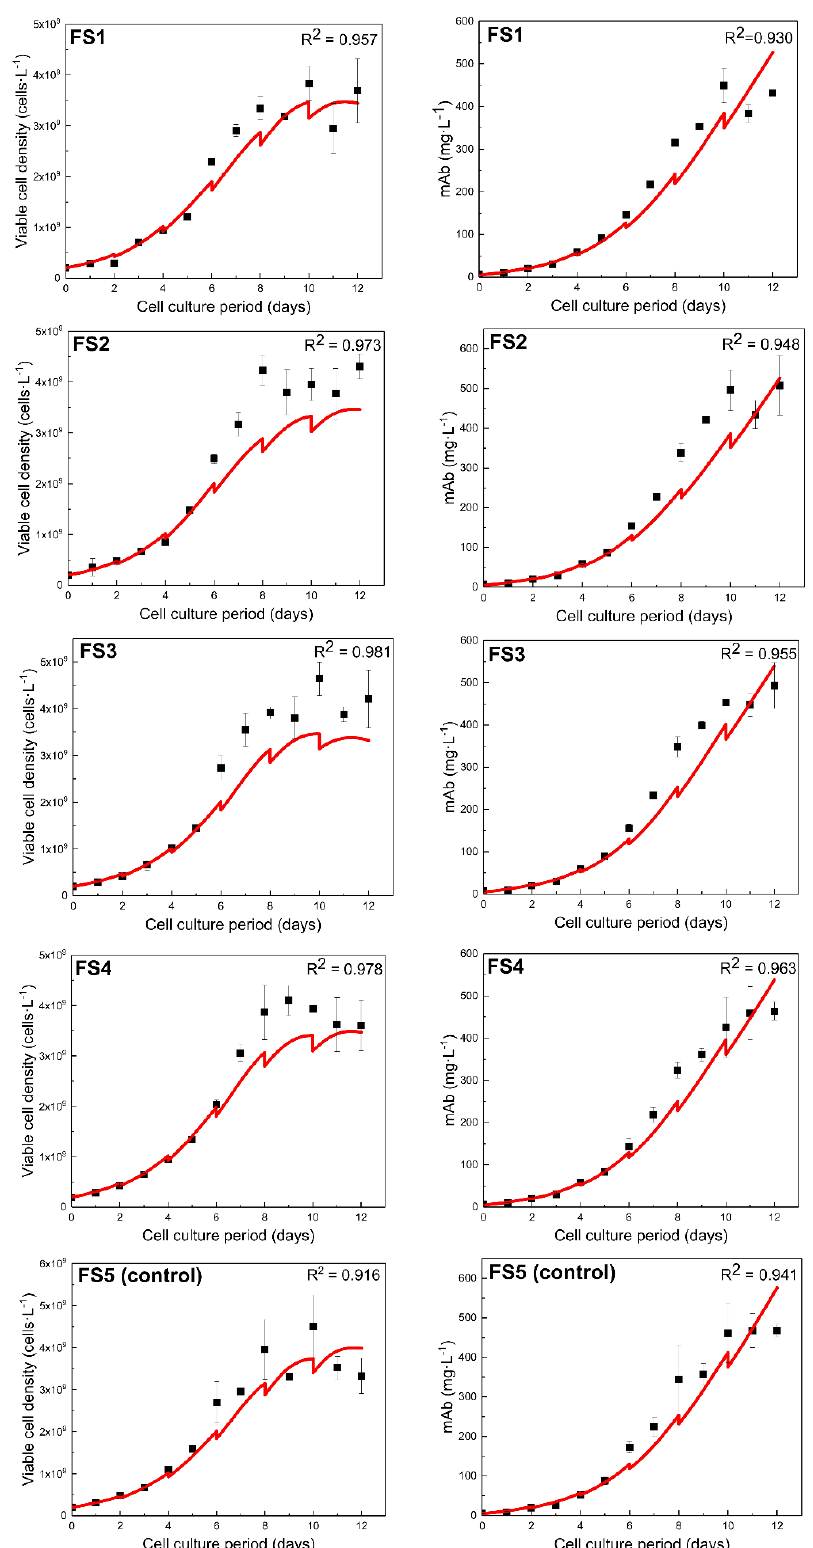
Figure 5. Model fitting (FS1) and predictions (FS2-5) to experimental data of viable cell density and antibody concentration for all the feeding strategies after parameter estimation. The R 2 values for model fitting to experimental data are also shown for each experiment. Model simulations are represented by the red line and the experimental data by the black dots.